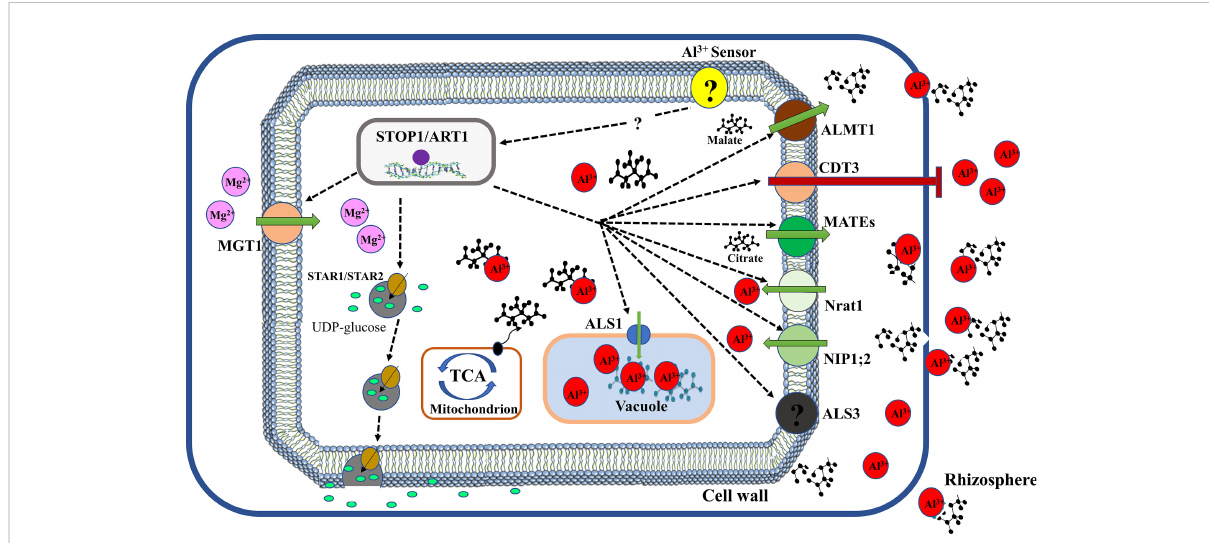
FIGURE 3 Transcriptional regulation of Al tolerance in plants. Al-stress is sensed by an unknown sensor and triggers activation of a C2H2-type zinc fi nger transcription factor (STOP1 or ART1) to initiate downstream signalling of Al tolerance genes. ALMT1, aluminum-activated malate transporter 1 for malate transport; CDT3, cadmium transport 3 block Al entry; MATEs, multidrug and toxic compound extrusion for citrate transport (e.g. OsFRDL4 and OsFRDL2 in rice, AtMATE1 in Arabidopsis); Nrat1, natural resistance-associated macrophage protein (Nramp) Al transporter 1 facilitate Al in fl ux; NIP1;2, plasma membrane-localized nodulin 26-like intrinsic protein transport Al-malate transporter in their cell; ALS3, Aluminum sensitive 3 promote Al in fl ux; ALS1, aluminum sensitive 1 enhance sequestration of Al-OA complex into the vacuole; TCA, tricarboxylic acid cycle mediate OA production; STAR1/STAR2, sensitive to aluminum rhizotoxicity 1/2 facilitate UDP-glucose transport; MGT1, magnesium transporter 1 for magnesium in fl